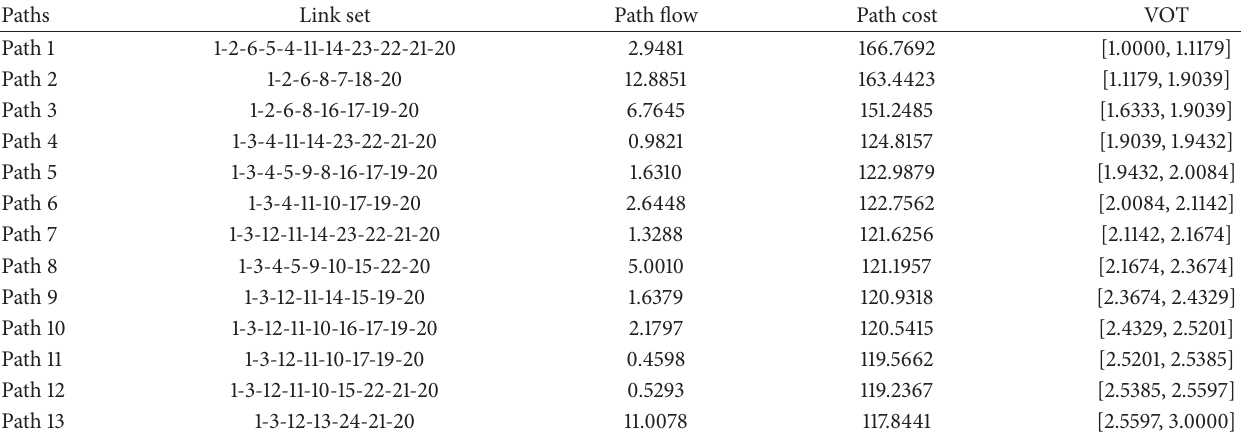
Table 1: Generated paths, path costs, and VOTs.